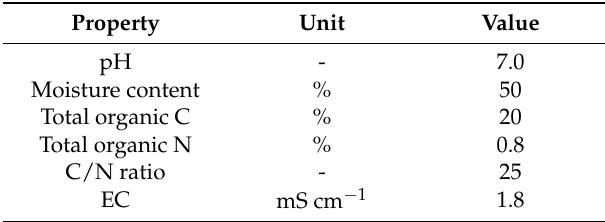
Table 1. Physicochemical parameters of the green compost (GC).